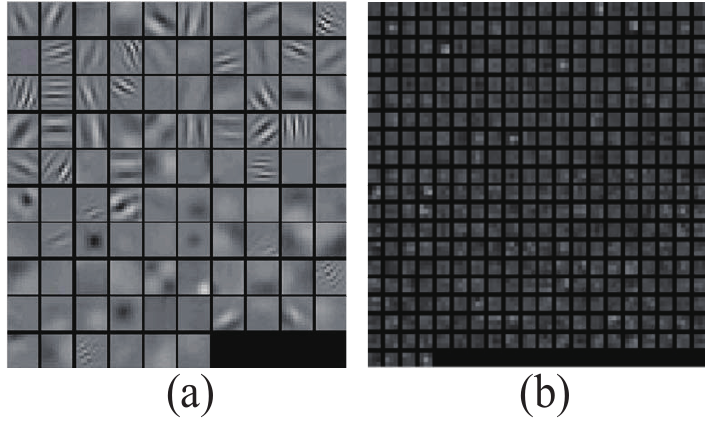
Figure 6. Some typical weights of the convolutional layers. ( a ) The weight for the first convolutional layer, which has 96 kernels. ( b ) The weight for the fourth convolutional layer that includes 384 kernels.